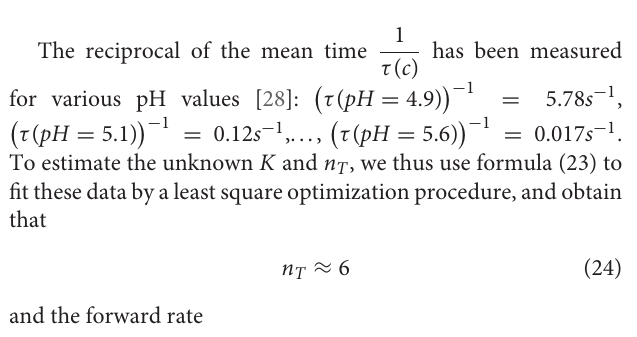
6 is estimated with Monte-Carlo simulations ( N 1000) (solid red line), and = =